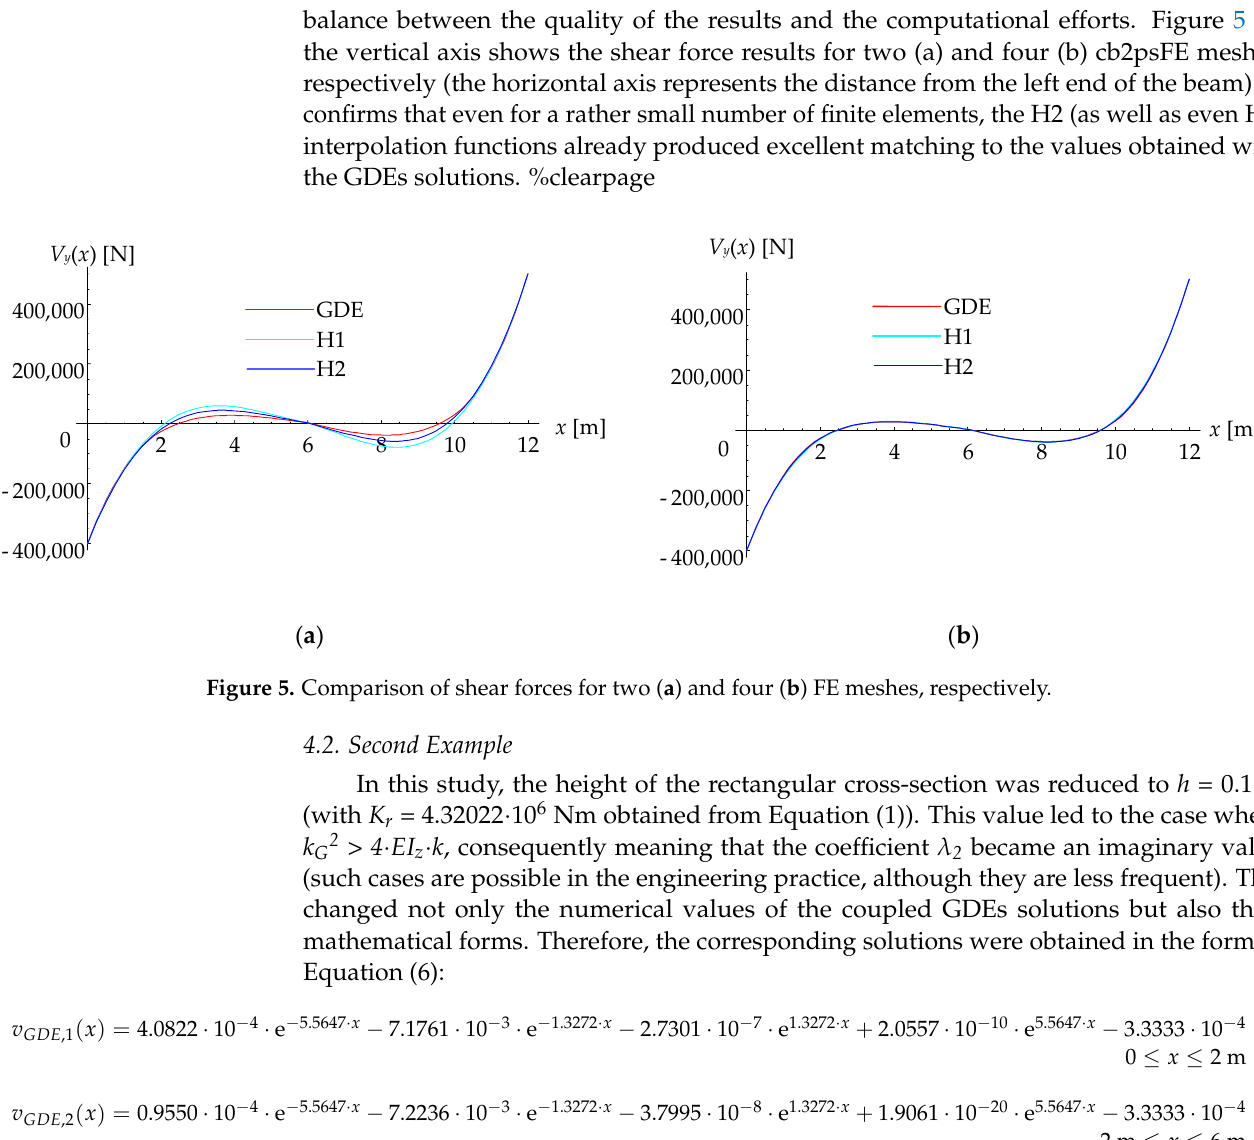
Figure 4. Comparison of bending moments for two ( a ) and eight ( b ) FE meshes, respectively. Among several approaches available for calculations of shear force functions, the direct interpolation of shear force values exhibited the optimal selection regarding the balance between the quality of the results and the computational efforts. Figure 5 on the vertical axis shows the shear force results for two (a) and four (b) cb2psFE meshes, respectively (the horizontal axis represents the distance from the left end of the beam). It confirms that even for a rather small number of finite elements, the H2 (as well as even H1) interpolation functions already produced excellent matching to the values obtained with the GDEs solutions.